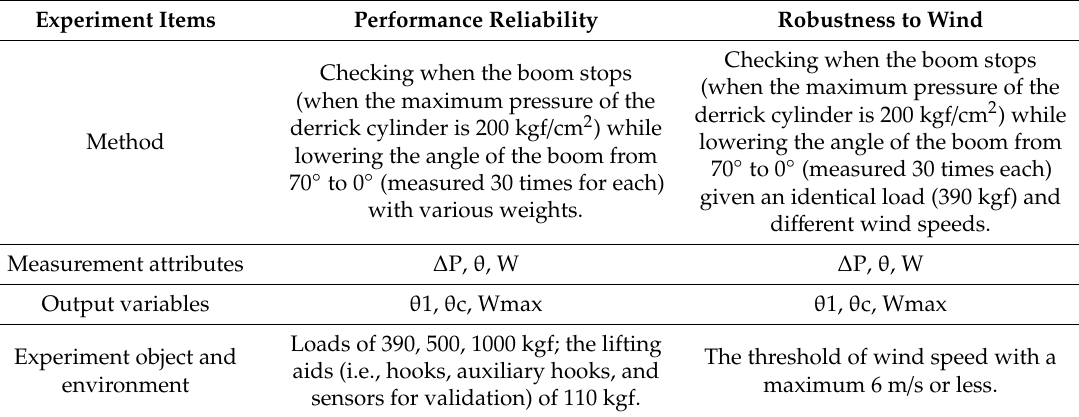
Figure 15. Experiment and lifting load scale. Table 4. Experiment method and environmental attributes.